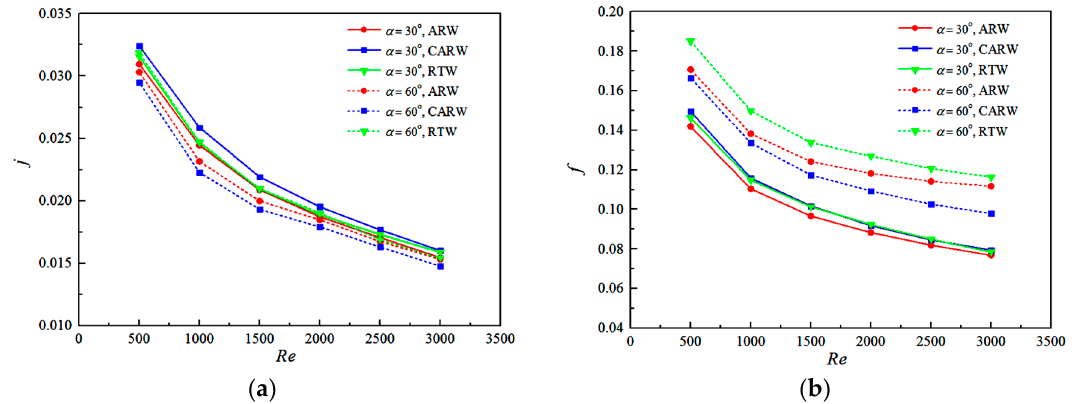
Figure 18. Effects on Colburn factor j and friction factor f at attack angles 30 ◦ and 60 ◦ [20]. ( a ) Colburn factor j . ( b ) Friction factor f . RTW: rectangular trapezoidal winglet; ARW: angle rectangular winglet; CARW: curved angle rectangular winglet.